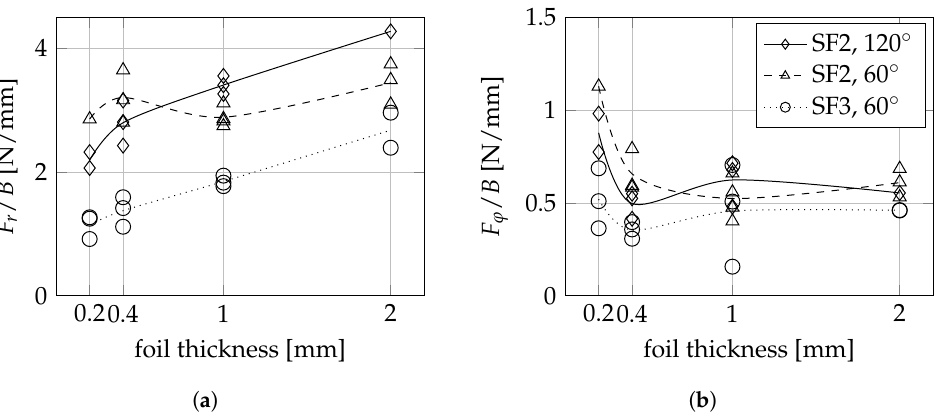
Figure 17. Average radial force ( a ) and average tangential force ( b ) over foil thickness for rub scenario S3, both seal fin geometries and foil